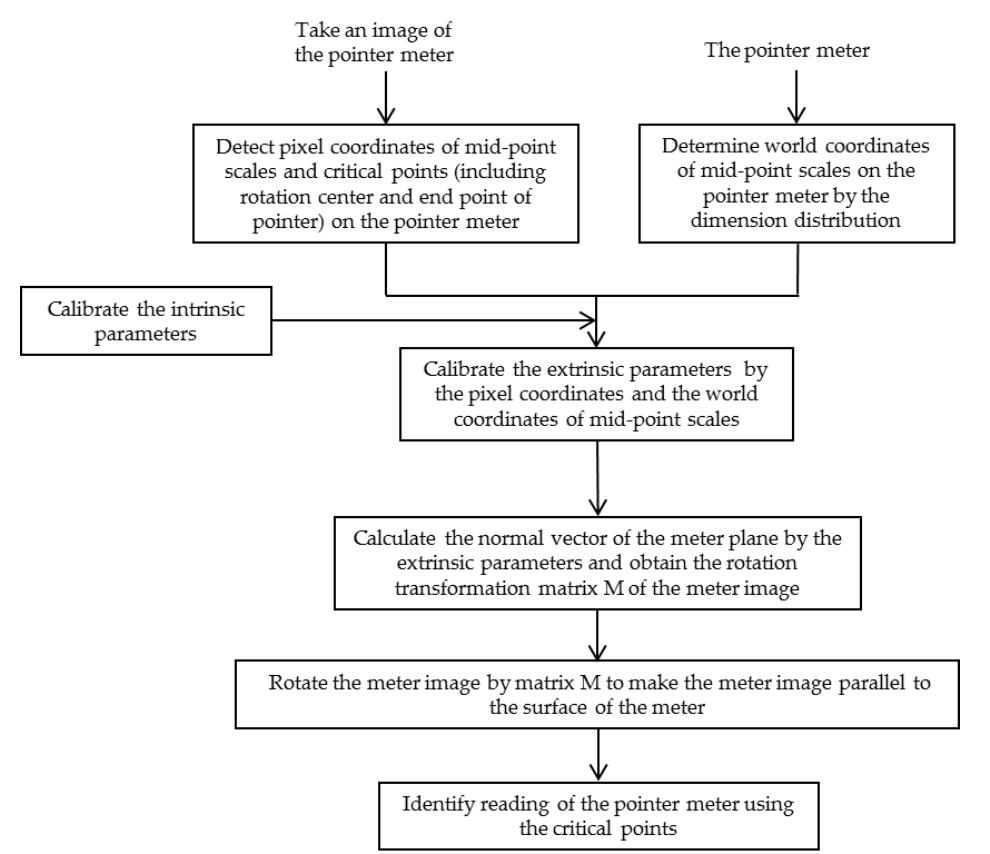
ff erent steps of measurement the readings of the pointer Figure 2. the different steps of measurement the readings of the pointer meter. Figure 2. The di